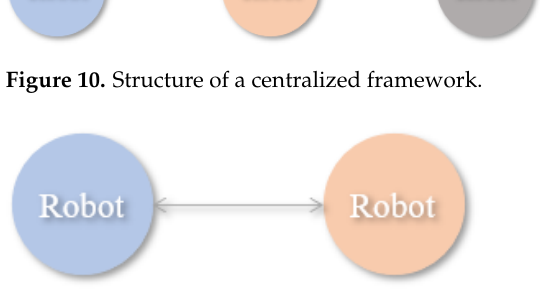
Figure 11. Structure of a decentralized